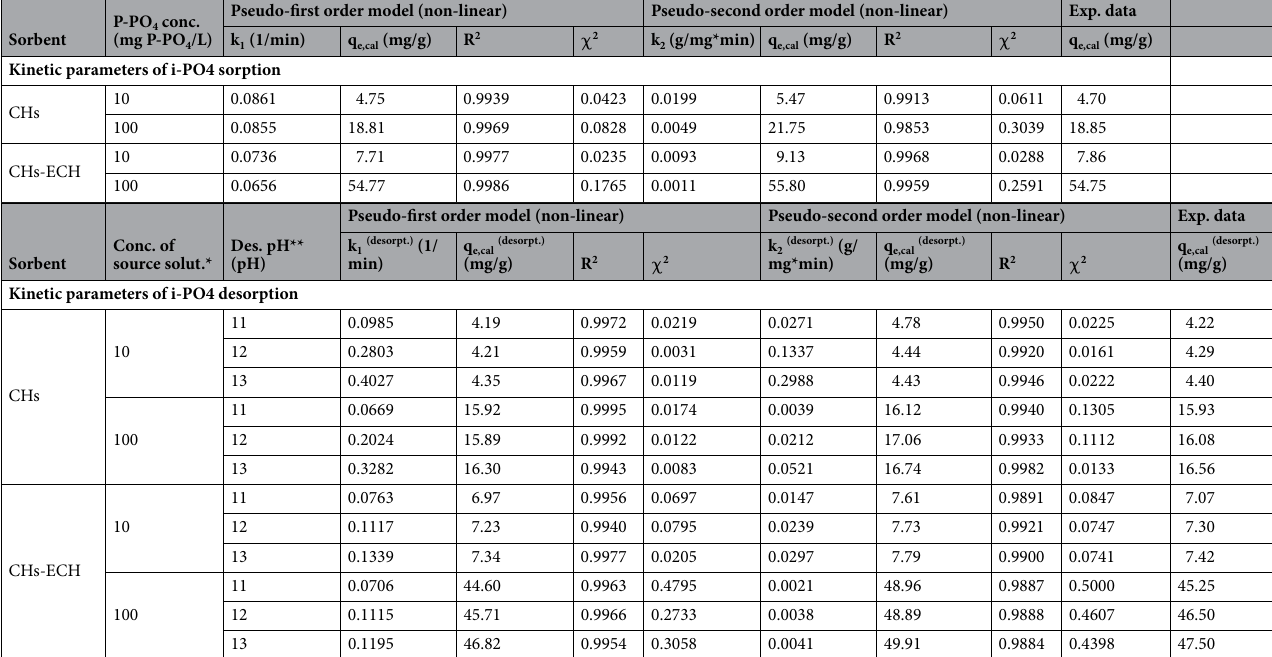
Table 1. Parameters of i-PO 4 sorption and desorption kinetics determined from the pseudo-first order model and pseudo-second order model. *Concentration of source solution (used for sorbent preparation)